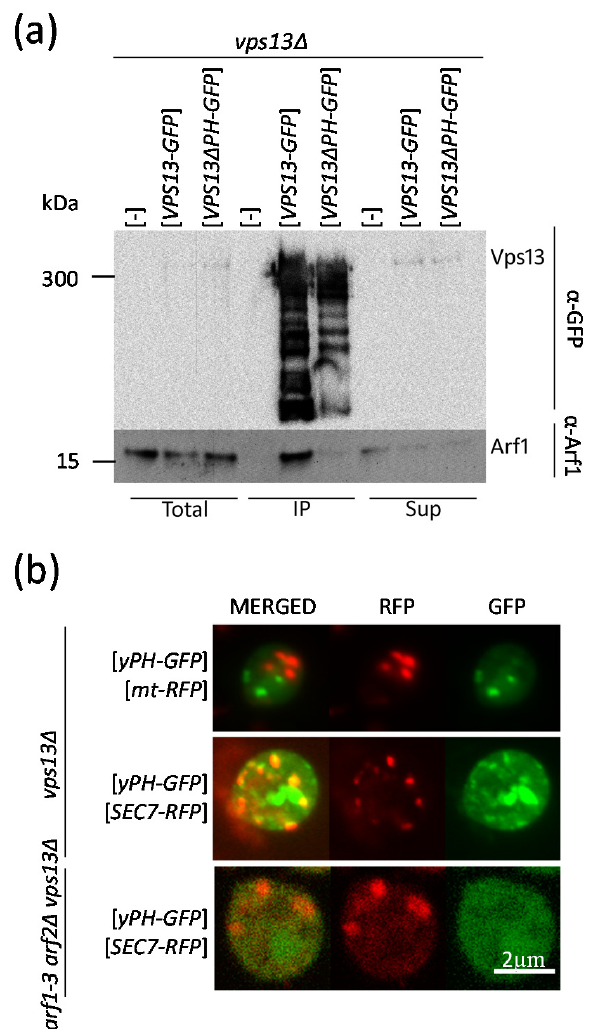
Figure 5. Vps13 interacts with Arf1 in vivo. ( a ) Cell extracts (total) from the vps13 ∆ strain transformed with an empty vector (-), a vector-expressing tagged Vps13 ( VPS13-GFP ) or a truncated, tagged version of Vps13 ( VPS13 ∆ PH-GFP ) were obtained. The extracts (Total), the fraction of extracts bound to GFP trap beads (IP) and non-bound material (Sup) were analyzed by immunoblotting using anti-GFP and anti-Arf1 antibodies. ( b ) Analysis of yPH-GFP localization in relation to mitochondria and Golgi marked with mt-RFP or Sec7-RFP, respectively, in vps13 ∆ or arf1-3 arf2 ∆ vps13 ∆ strains observed by fluorescence microscopy.